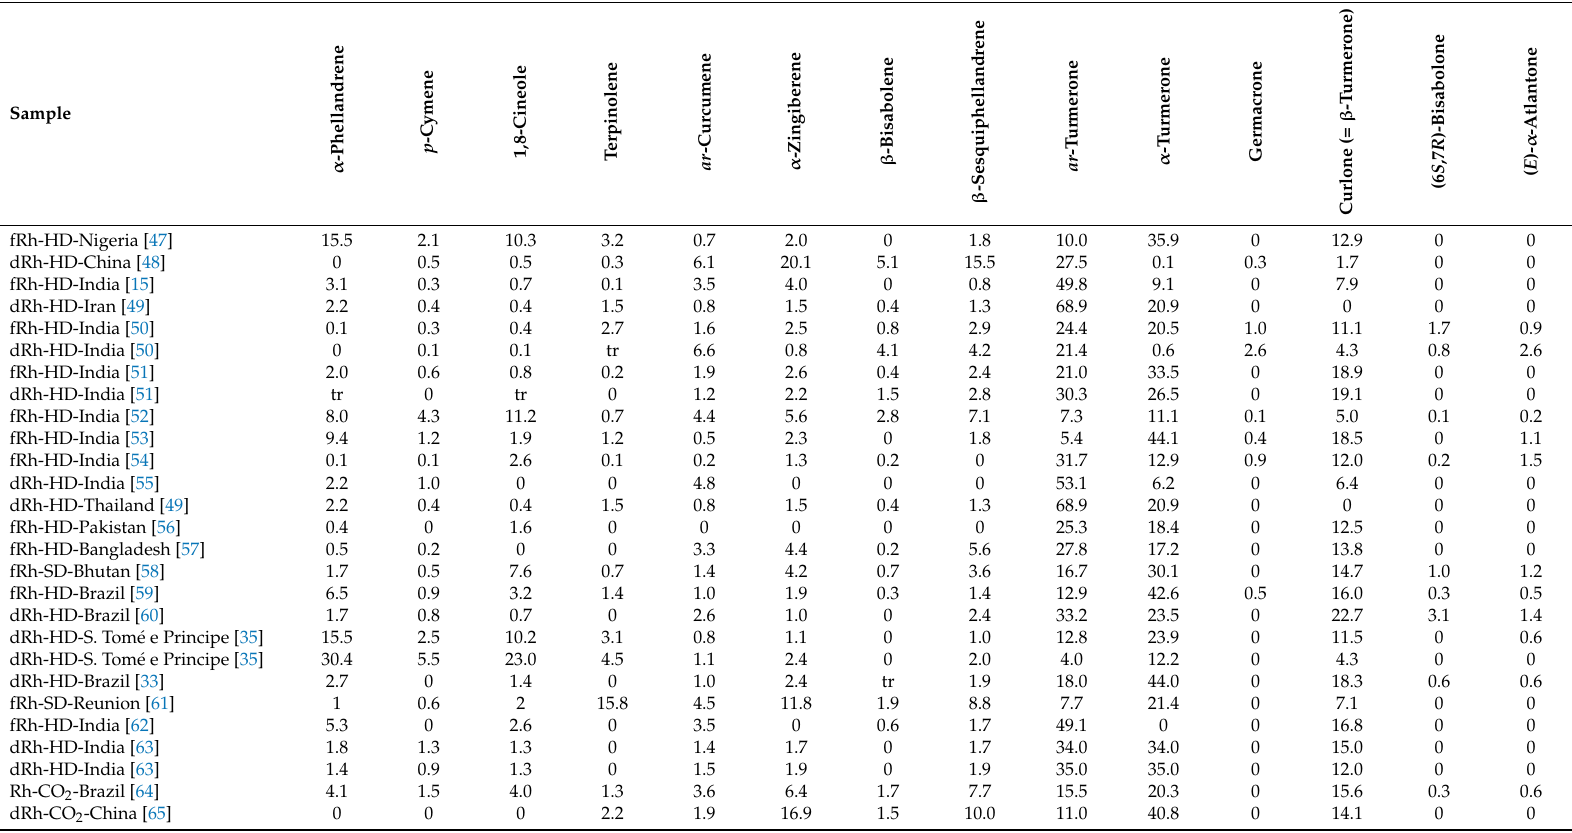
Table 5. Chemical composition of Curcuma longa rhizome volatile oils from the published